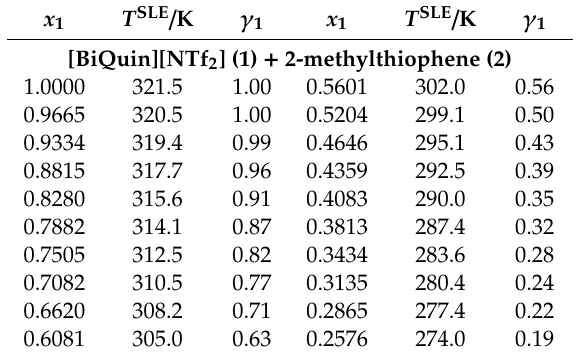
Table 3. Experimental (solid + liquid) phase equilibrium data, SLE, for {IL (1) + 2-methylthiophene (2)} binary systems at pressure p = 0.1 MPa: x 1 is the ionic liquid mole fraction; T SLE is the equilibrium temperature; γ 1 is the activity coe ffi cient of the IL obtained with the NRTL equation a,b . x 1